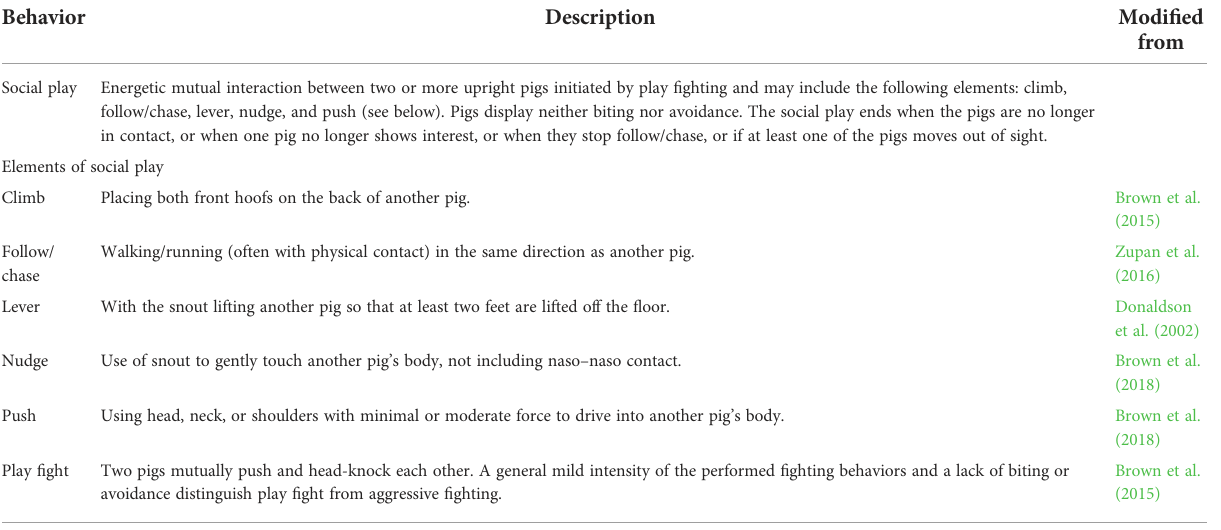
TABLE 2 Ethogram of behaviors constituting social play in domesticated pigs ( Sus scrofa ). Behavior Description Modi fi ed